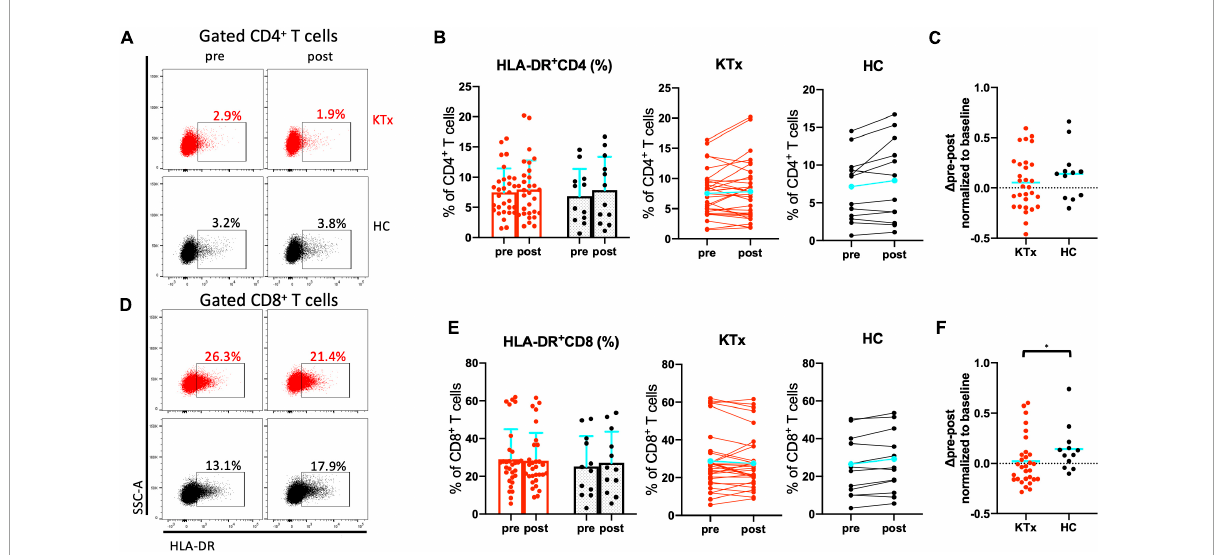
FIGURE4 Activated CD8 + T cells were induced by SARS-CoV-2 mRNA vaccination in HCs. Representative gating strategies and scatter plots of activated HLA-DR + , PD1 + , and Treg cells among T cell subsets in the two groups pre- and post-vaccination (A,D) . Comparison of the proportions and change in proportions of HLA-DR + cells among CD4 + (B) and CD8 + (E) T cells in KTx recipients (left) and HCs (right) as measured by flow cytometry. Normalized increases in HLA-DR + cells among CD4 + (C) and CD8 + (F) T cells between pre- and post-vaccination. Bar plots depict mean ± SD. Blue lines and bars represent means. Data were analyzed using the Mann-Whitney U test (* P < 0.05).